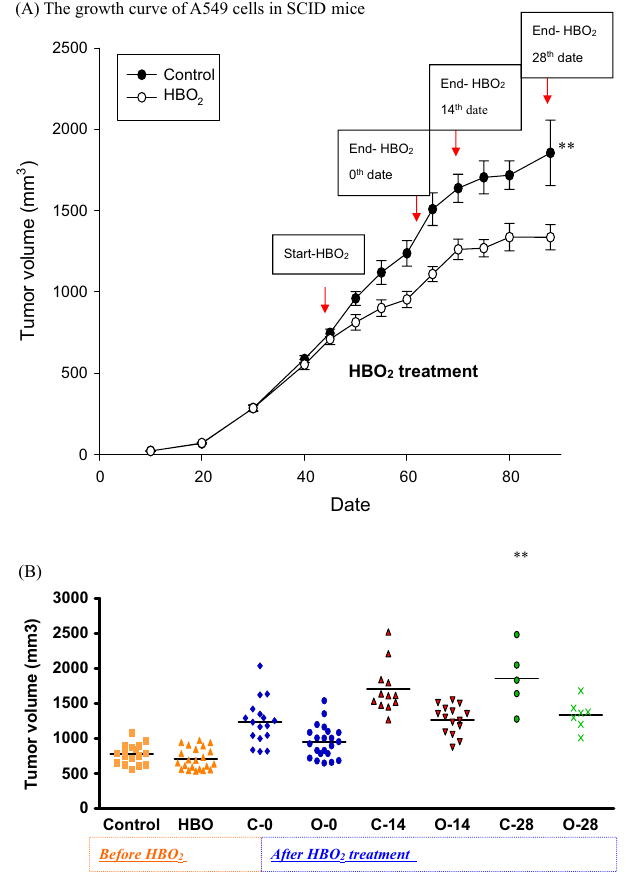
Figure 1. A549-tumor transferred SCID mice were either non-exposed or exposed to HBO 2 (98% O 2 , 2% CO 2 at 2.5 ATAfor2.5 ATA 90 min 5 times in a week beginning at the 45th date after tumor injection and were monitored for the tumor volume twice in a week. Tumor volume was calculated as length (L) × width (W) × height (H). ( A ) The growth curve of A549 cells in SCID mice. Only the mice with tumor volume larger than 500mm 3 were selected ( B ) The comparison of tumor volume among groups of mice before or after HBOT. For each dot-point represents the tumor volume of one A549-tumor transferred SCID mice. HBOT effectively suppressed tumor growth after 14 days (** P < 0.01) and 28 days (** P < 0.01) of tumor transfer. (C-0 represents for control mice at the first date comparing with HBOT mice; O-0 represents for mice receiving the first date of HBOT; C-14 days represents for control mice after 14 days comparing with HBOT mice; O-14 days represents for mice after 14 days of HBOT; C-28 days represents for control mice after 28 days comparing with HBOT mice; O-28 days represents for mice after 28 days of